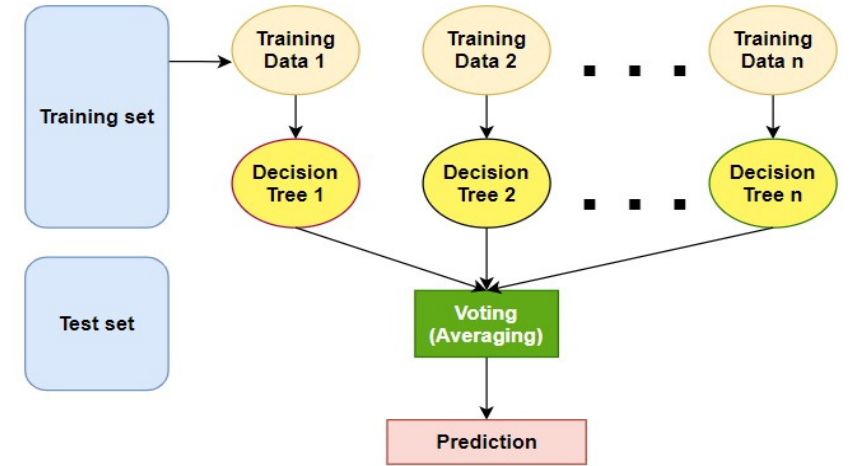
Figure 4. Random forest model algorithms .